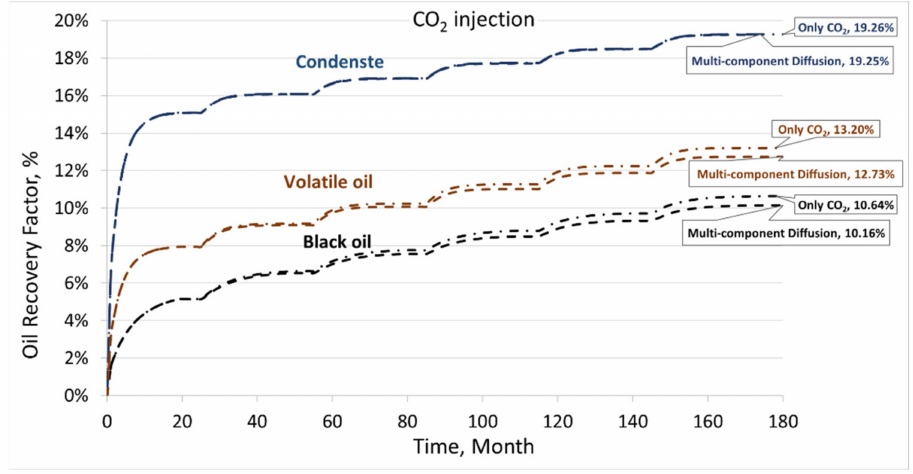
Figure 12. Impact of multicomponent diffusion on the production from different reservoir